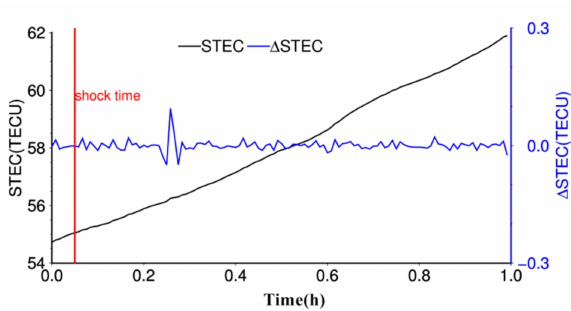
Figure 12. Time series of STEC and ∆ STEC in the sight line of PRN09-SCYY.